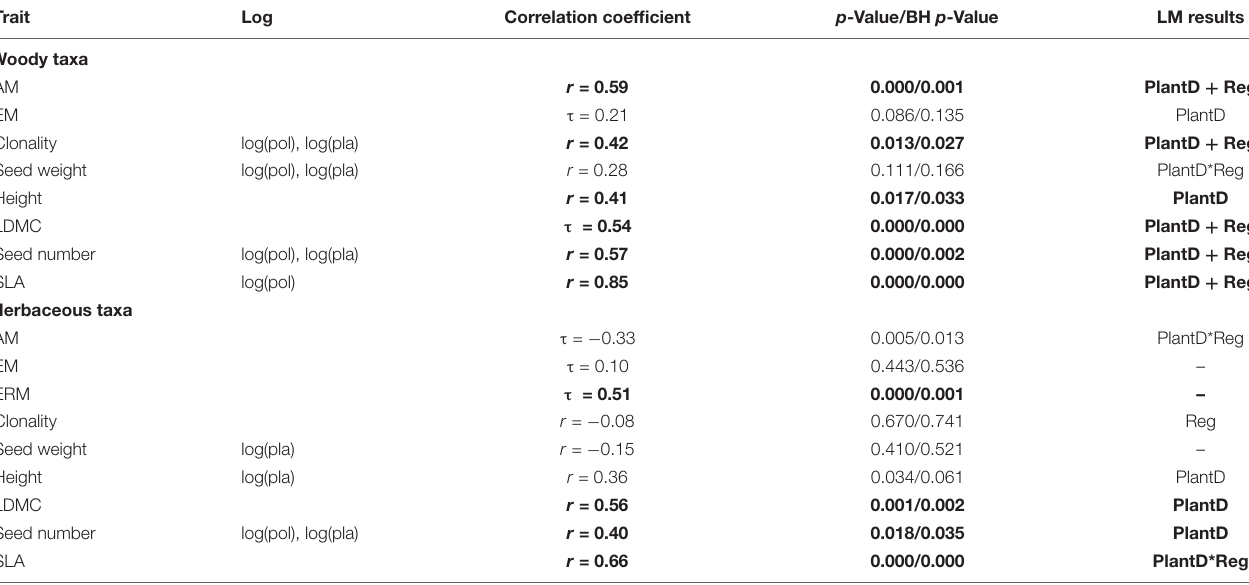
TABLE 2 | Correlation test results for pollen- and plant-based community weighted mean (CWM) trait values (functional trait composition).